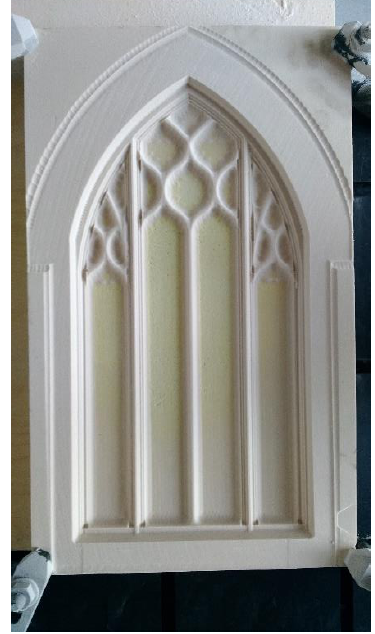
Figure 3: Milling process showing layer of